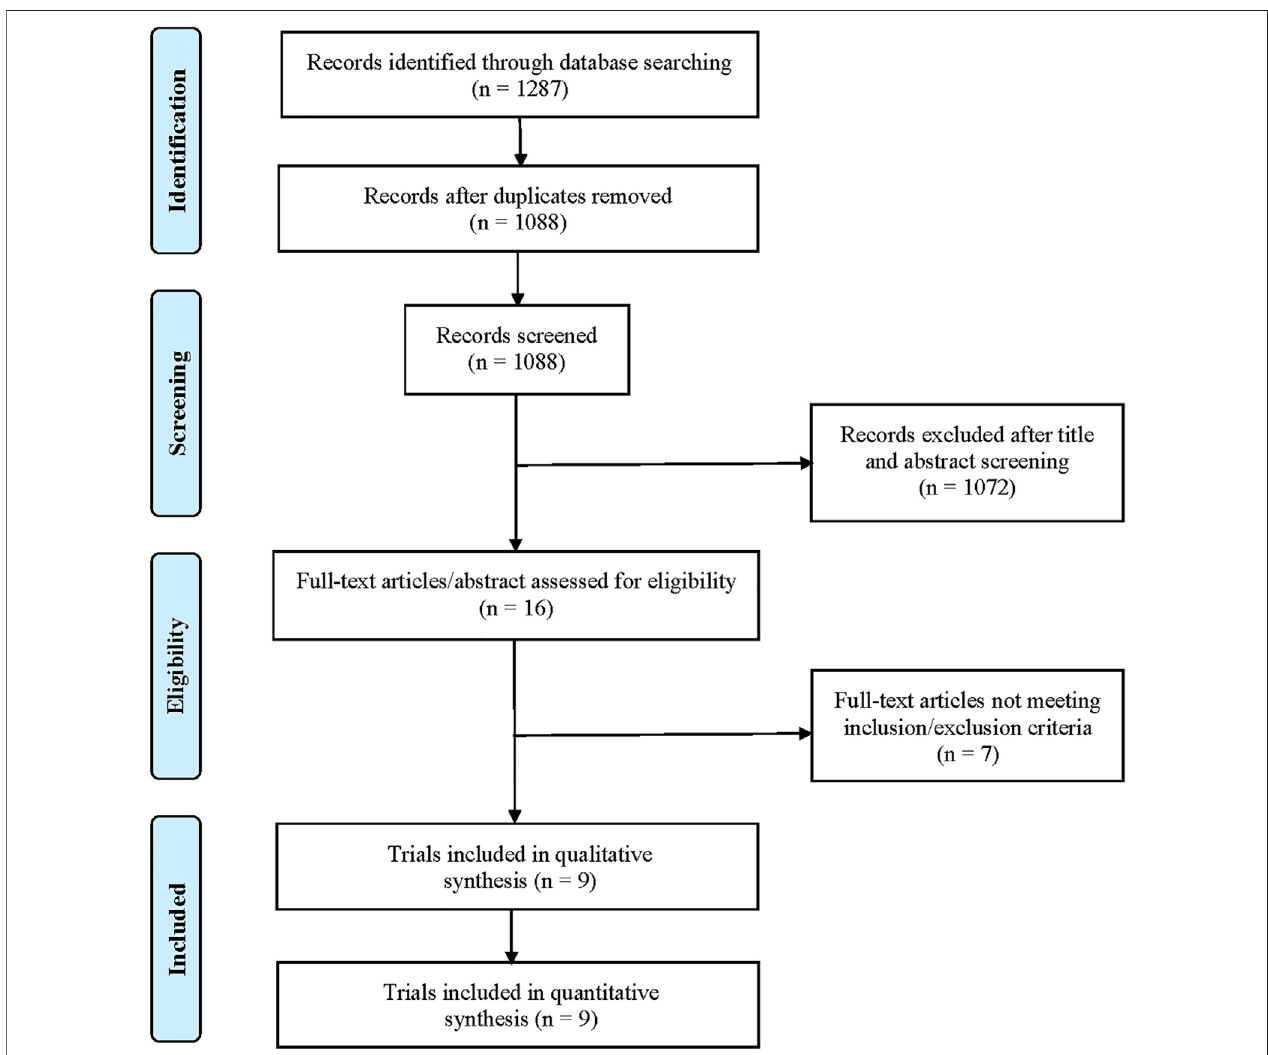
FIGURE 1 | Flow diagram of study inclusion and